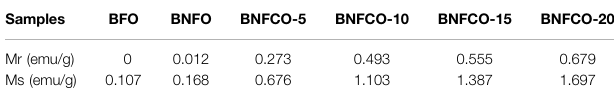
TABLE 5 | M r and M s value of samples at different doping